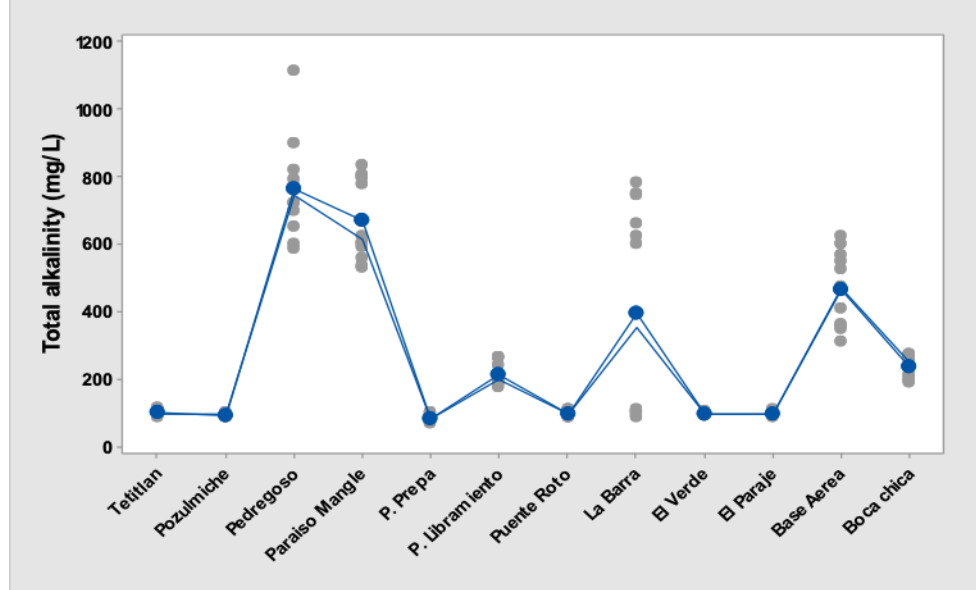
Figure 6. Total alkalinity values in each location; the grey points refer to the data dispersion in relation to the mean represented by the blue line.